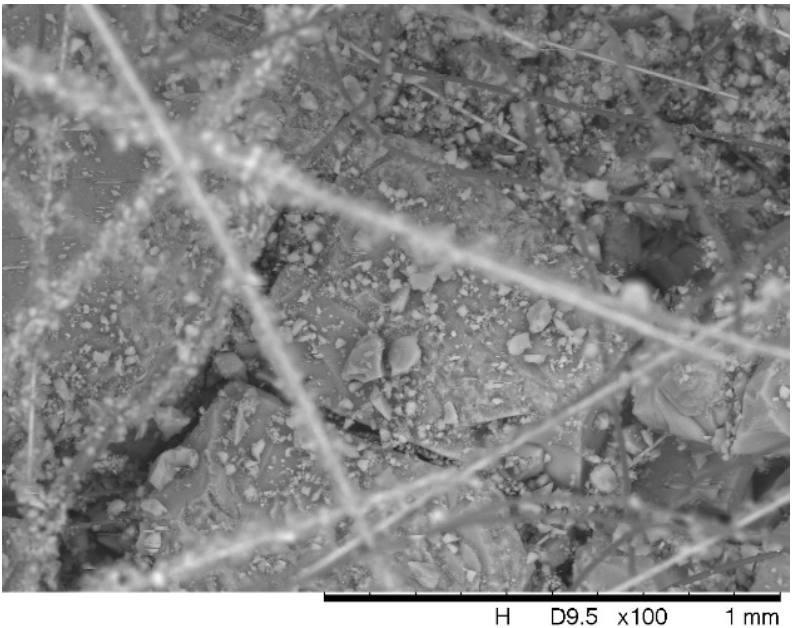
Figure 4. SEM image of the isothermally annealed sample.